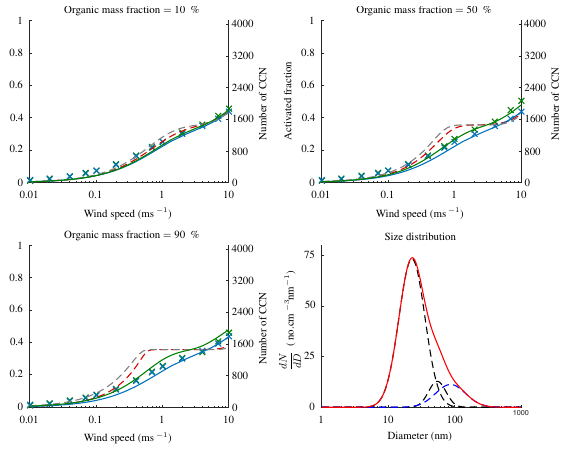
Figure 10. Same as Fig. 7 for the urban